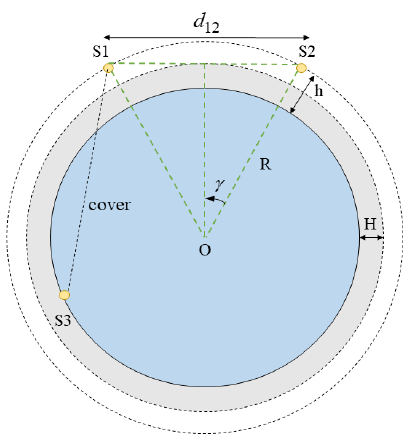
Figure 4. Scenario of establishing LISLs between the same orbit.